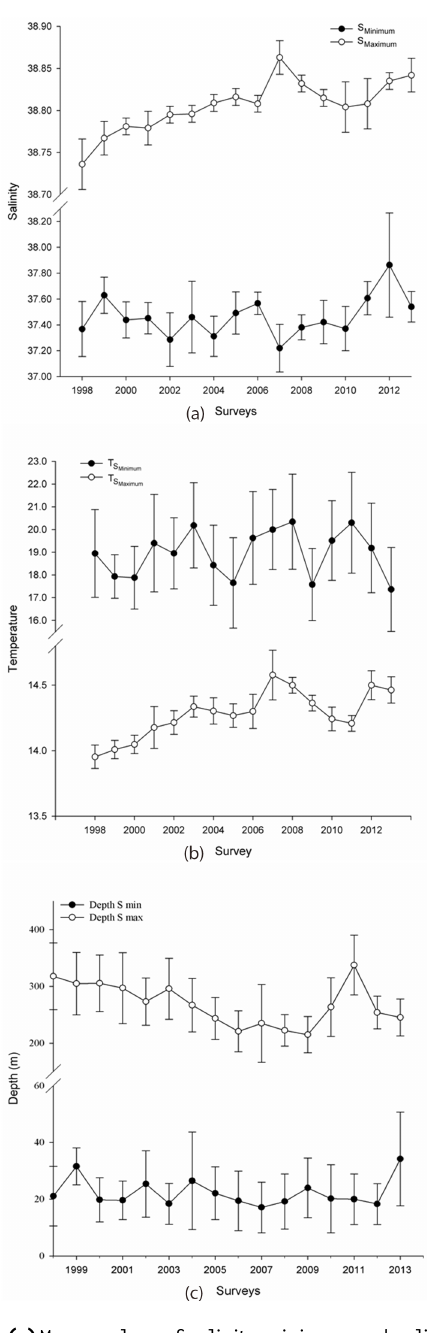
Figure 3. (a) Mean values of salinity minimum and salinity max- imum recorded in the period 1998–2013. (b) Mean potential tem- perature and (c) mean depth recorded at depth of salinity minimum and salinity maximum.